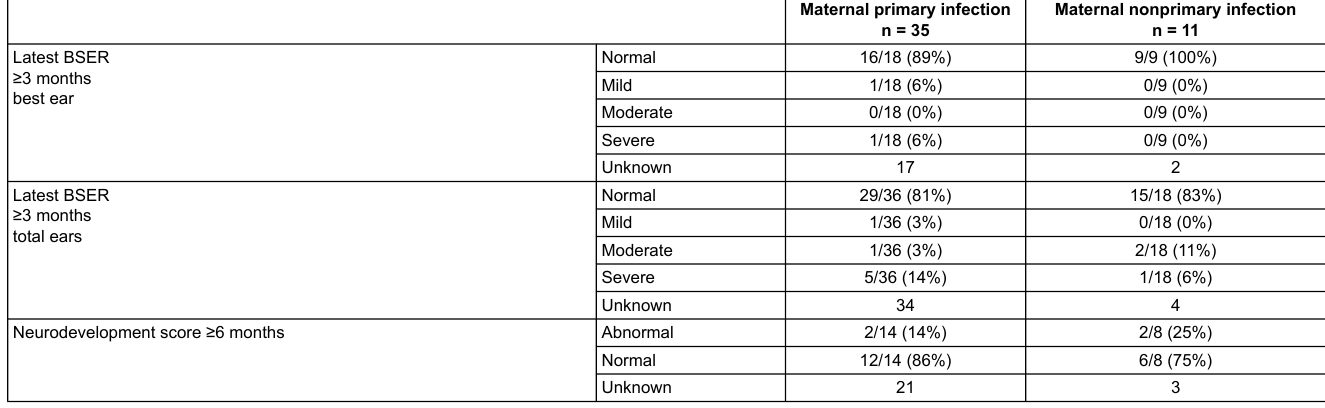
Table 4: Audiological and neurodevelopmental outcome at 3 months of age and onwards, categorised by newborns born to mothers with a primary versus a nonprimary infec- tion.